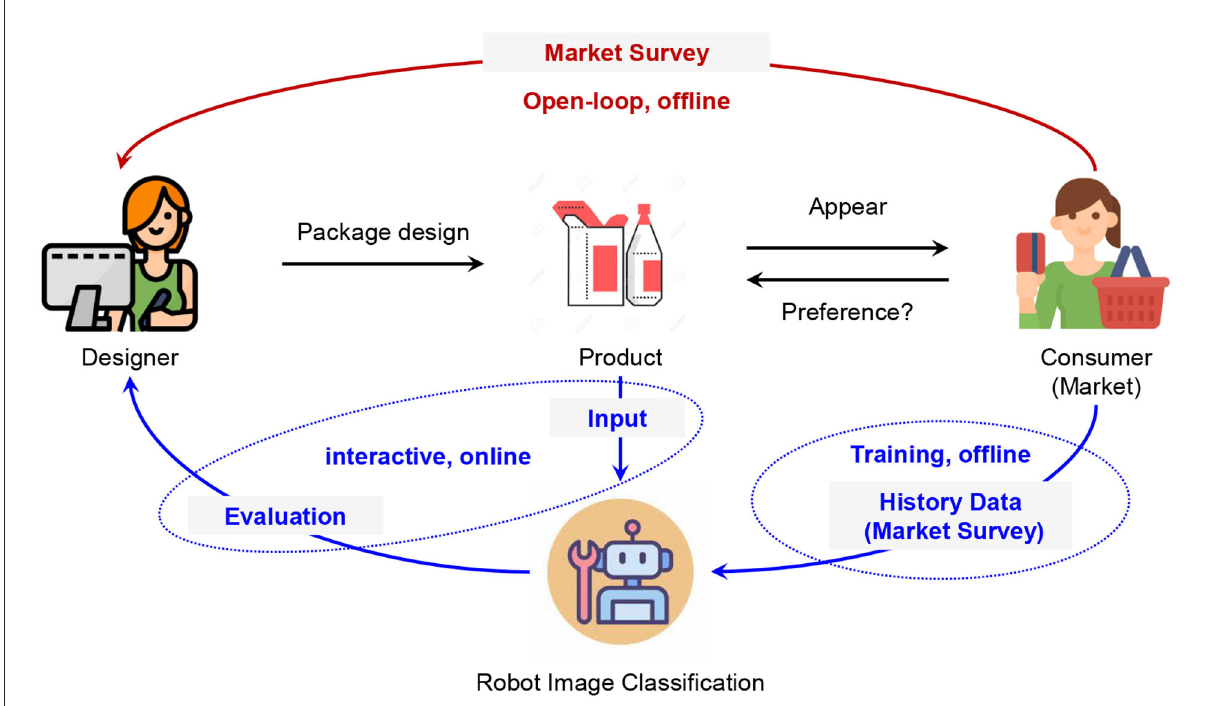
FIGURE1 Comparison of the processes of traditional open-loop package design and robot-assisted interactive package